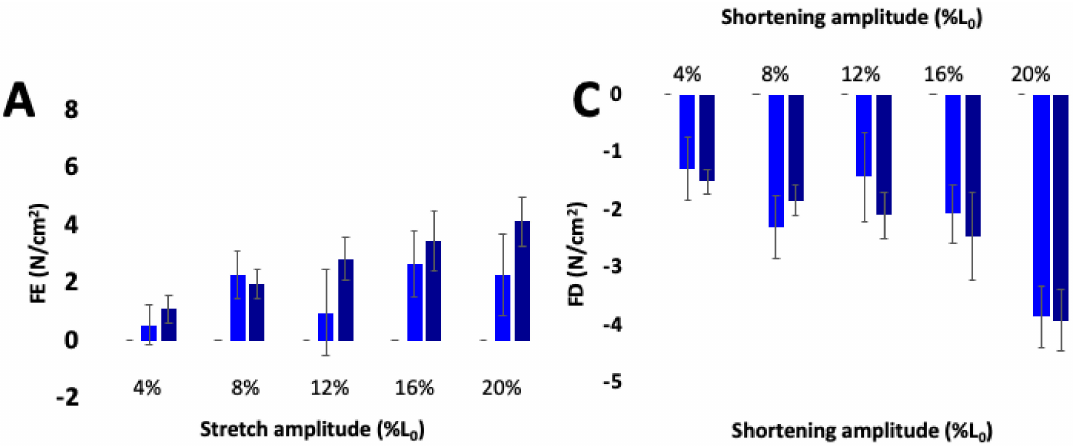
Figure 4. Activation increases titin-based force and sti ff ness of wild type psoas myofibrils, but not mdm myofibrils, during stretch. Stress (nN / µ m 2 ) vs. sarcomere length ( µ m) of single psoas myofibrils from the wild type (WT, black open symbols) and muscular dystrophy with myositis (mdm, gray filled symbols) mice during active (diamonds) and passive stretch (circles). There is no di ff erence in passive stress between WT and mdm myofibrils. Actively stretched WT myofibrils are sti ff er than active mdm and both passive mdm and WT, while actively stretched mdm myofibrils do not di ff er in sti ff ness from passively stretched mdm and WT myofibrils. Reproduced with permission from Powers et al. [25]. Copyright 2016, The Company of Biologists